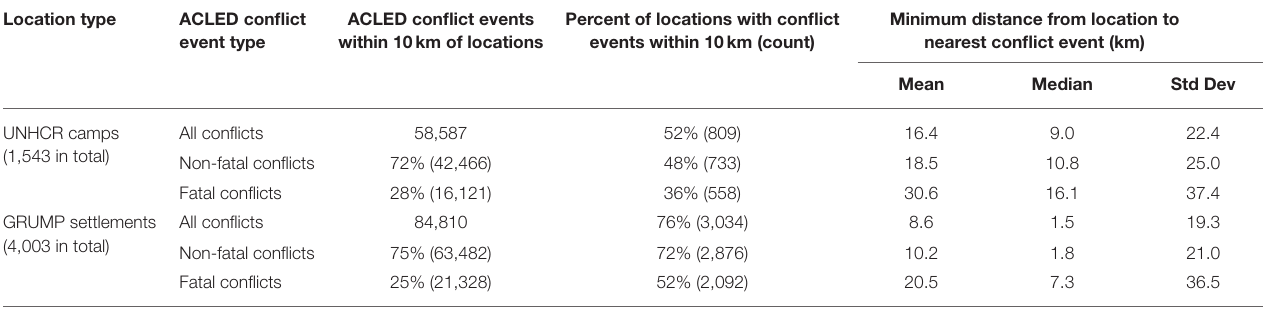
TABLE 1 | Summary of non-fatal (0 fatalities) and fatal ( > 0 fatalities) conflict event incidence within 10km of UNHCR camp and GRUMP settlement locations and proximity to nearest conflict event. Location type